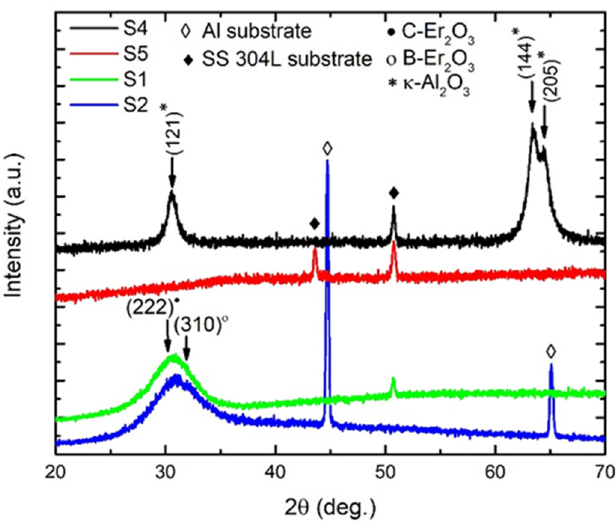
Figure 7. XRD analysis of magnetron sputtered layers: S1, S2, S4, and S5; A broad peak was observed for S1 and S2, which corresponds to erbium oxide in stable cubic or metastable monoclinic phase; The κ -Al 2 O 3 crystalline phase is highlighted for S4, while for S5, no diffraction peak could be ob- served.